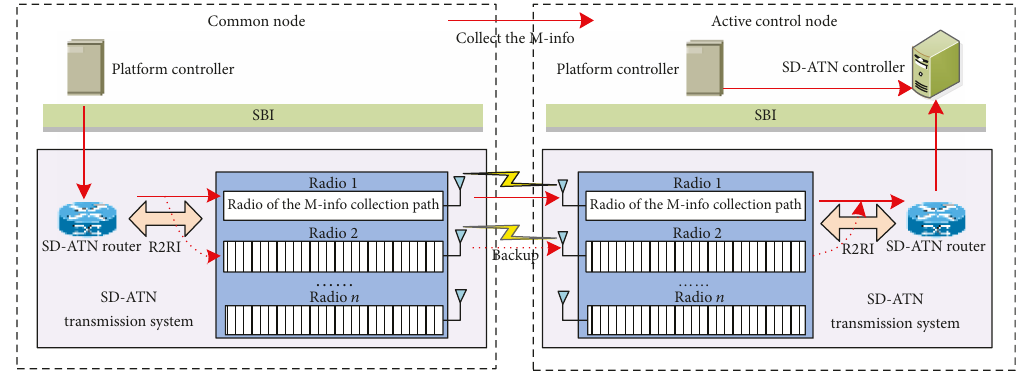
Figure 2: Overview of the